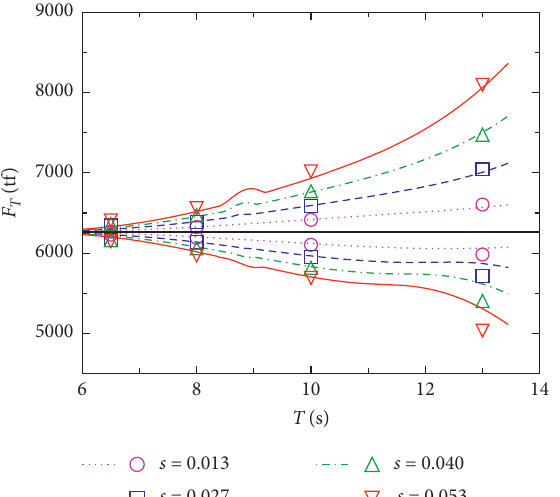
Figure 6: Tension force of a single mooring cable as a function of wave period (T). Solid lines are numerical simulation results by continuous calculation; open markers are experimental